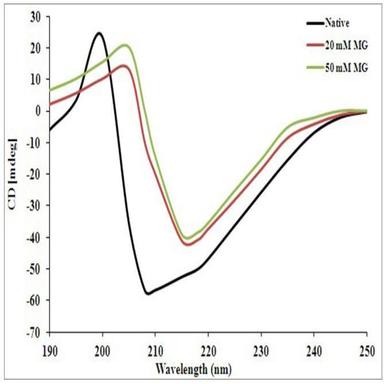
Circular dichroism spectroscopy. Far UV-CD spectra of hTF in native form and hTF incubated with varying concentration (20 mM and 50 mM) of MG for specified time period (day 12). The concentration of hTF used for this was 6 μM and the recording range was 190–250 nm.